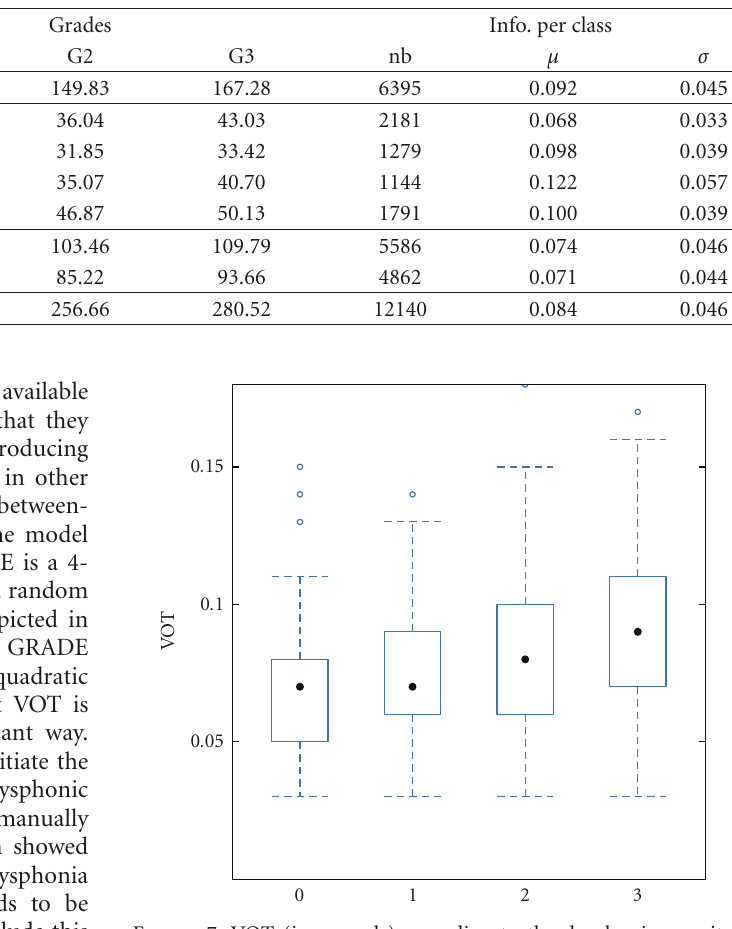
Table 4: Total duration in seconds per phonetic class and per grade as well as the number of phonemes (nb), their averaged duration ( μ ) and associated standard deviation ( σ ).